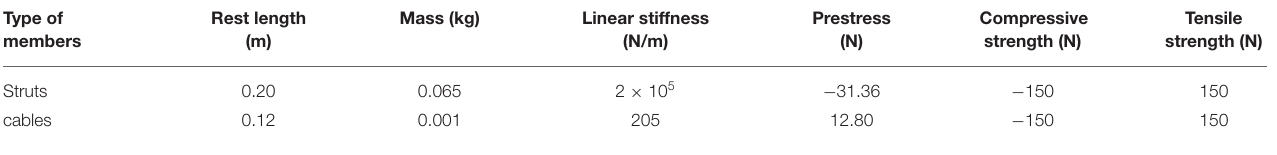
TABLE 4 | Rest lengths at initial state and mechanical properties of elements. Type of